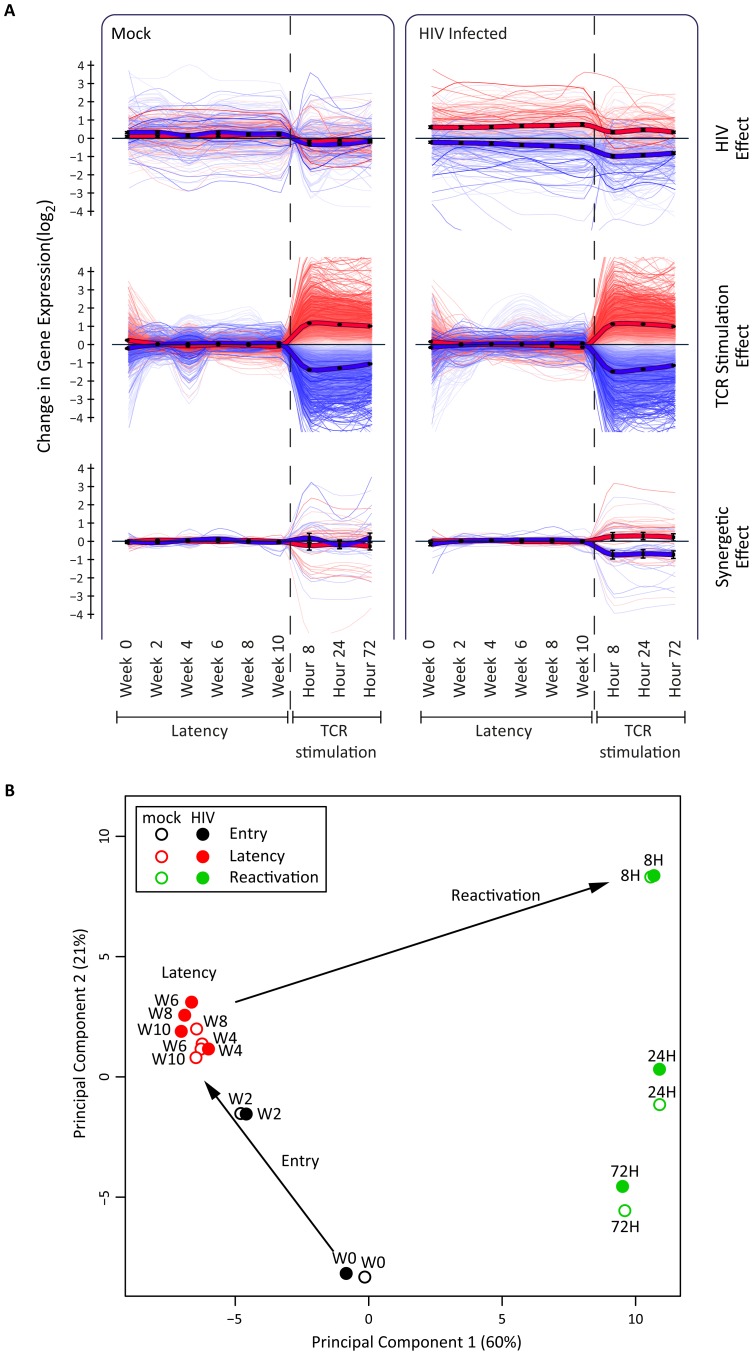
Host transcriptional response in latency and reactivation in a primary CD4+ T cell model.Panel A. Illustrated are 9729 genes with statistically significant association to at least one of the two experimental conditions, HIV infection and TCR stimulation, as evaluated by 2-way analysis of variance of 14513 expressed genes (FDR<0.05). Data are presented in three non-exclusive groups: those regulated in concordance with viral presence (345 genes, top panel), those regulated in concordance with TCR-stimulation 9647 genes, (middle panel), and those showing non-additive synergetic effects by viral presence and TCR stimulation (59 genes, bottom panel). The bold lines represent the group average, and color intensities are proportional to statistical significance of the effects within each group. Panel B. Principal component analysis of host whole-transcriptome data supports a three-step model of entry-latency-reactivation. There is a transcriptionally coherent latency phase between week 4 and week 10, and a distinct reactivation phase at 8, 24, and 72 hours after TCR stimulation. All data, including differentially expressed genes and enrichment analysis, are available at http://litchi.labtelenti.org.